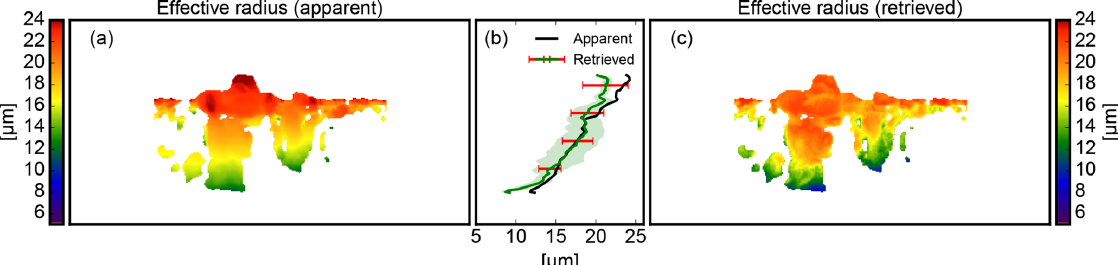
Figure 21. Retrieval comparison between the apparent effective radius (a) and the retrieved mean effective radius (c) for a cloud scene that was not included in the forward ensemble. (a) Apparent effective radius (cid:104) r eff (cid:105) app for the airborne perspective, (b) mean and standard deviation of the apparent (black) and retrieved (green) vertical effective radius profile with the mean statistical retrieval uncertainty (red error bars). (c) Retrieved mean effective radius for the airborne